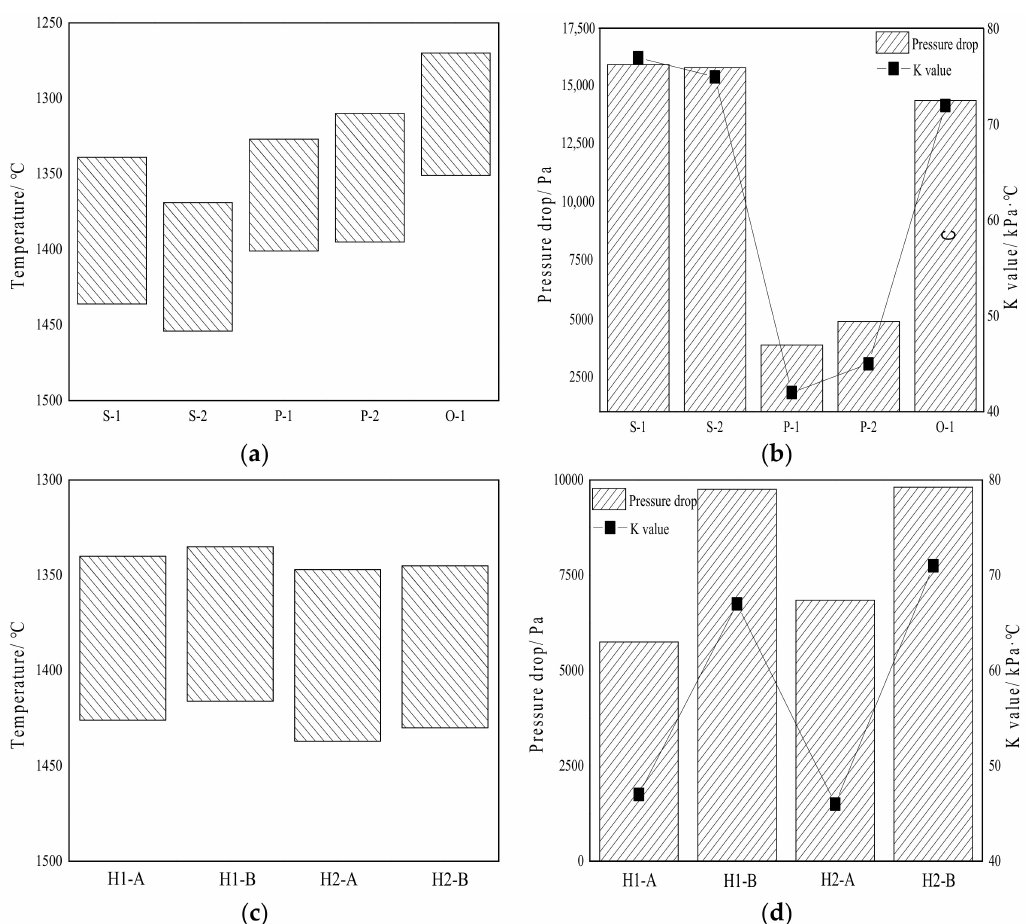
Figure 5. Melting–dropping properties of samples tested. ( a , b ) Cohesive zone pressure drops and K values for single iron ore samples. ( c , d ) Cohesive zone pressure drops and K values for mixed iron ore